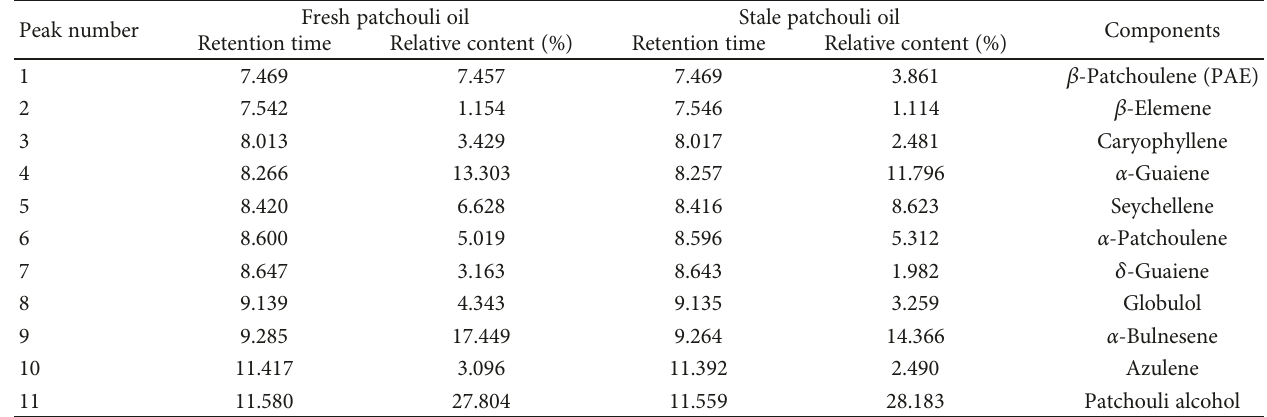
Table 2: Components of common peaks in fi ngerprint of patchouli